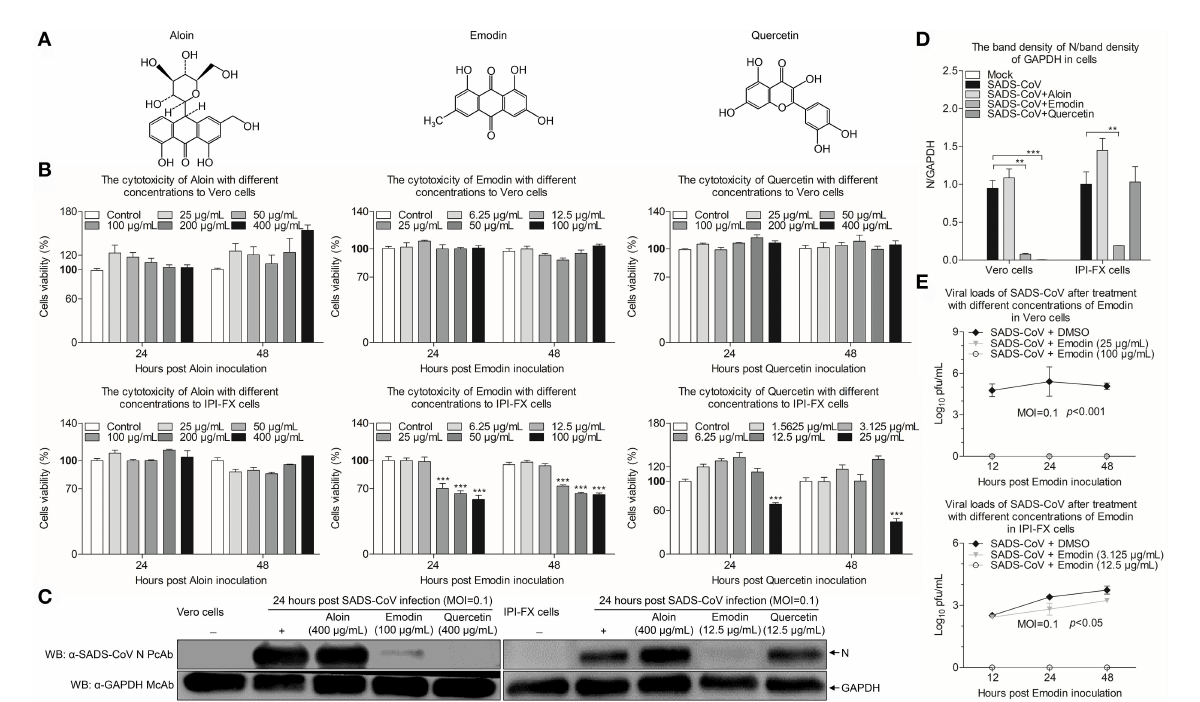
FIGURE2 Emodin from Ae inhibits SADS-CoV replication in vitro . (A) Chemical structures of Aloin, Emodin, and Quercetin. (B) The cytotoxicity of Aloin, Emodin, and Quercetin in Vero and IPI-FX cells. Vero and IPI-FX cells were co-incubated with various concentrations of Aloin (25–400 µ g/ml), Emodin (6.25–100 µ g/ml), and Quercetin (1.5625–400 µ g/ml) or 0.1% DMSO for 24h and 48h prior to the CCK-8 assay. (C) Vero and IPI-FX cells were pre-incubated with Aloin, Emodin, and Quercetin, or 0.1% DMSO at a safe concentration for 1h, followed by infection with SADS-CoV at an MOI of 0.1. After 1.5h, the cells were re-treated with Aloin, Emodin, and Quercetin or the normal medium. At 24h post-inoculation, the expression levels of N and GAPDH proteins in the cell lysates were detected by Western blot using anti-SADS-CoV N polyclonal antibody and anti-GAPDH monoclonal antibody. (D) The relative quantity of SADS-CoV N protein described in (C) . (E) At indicated time points (12h, 24h, and 48h), the viral titers in the cell lysates were determined by the TCID 50 assay. Results are representative of three independent experiments (mean ± SD). n = 8 or 3. ** p < 0.01, *** p <